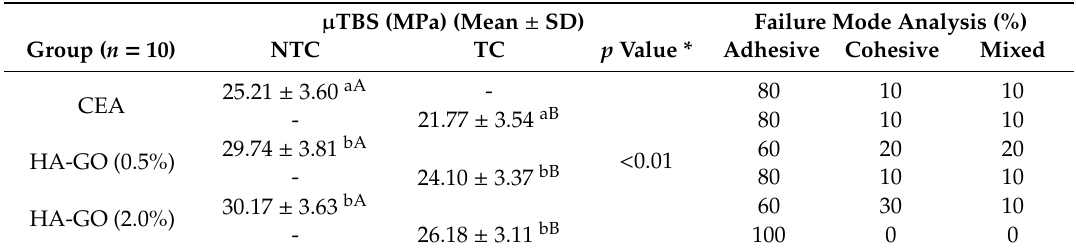
Table 2. Mean and SD of microtensile bond strength and failure modes among the tested study groups μ TBS (MPa) (Mean ± SD)